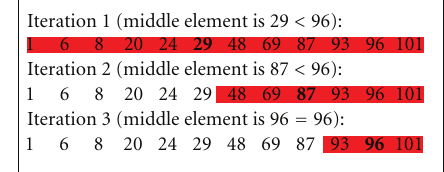
Figure 4: Binary search demonstration. The searched item is